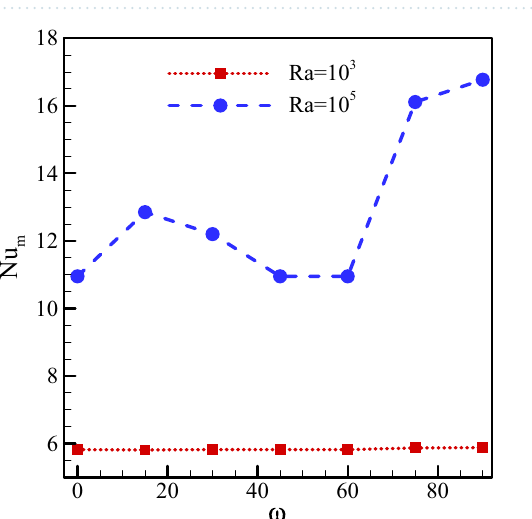
Figure 5. Variations in the local Nu along ( a ) the warm lower wall and ( b ) the warm left wall, for different Rayleigh numbers (dashed lines represent the 0° magnetic field angle and dash-dot lines represent the 90° magnetic field angle).